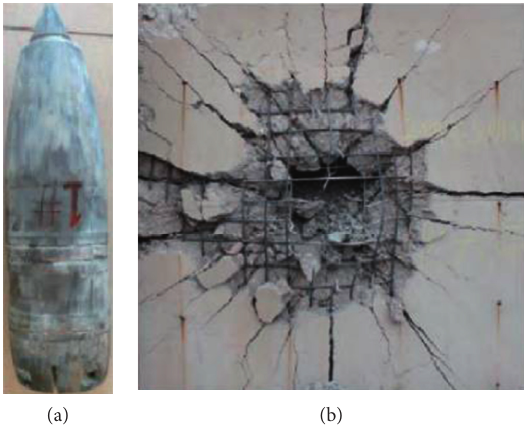
Figure 13: (a) The projectile; (b) the reinforced concrete